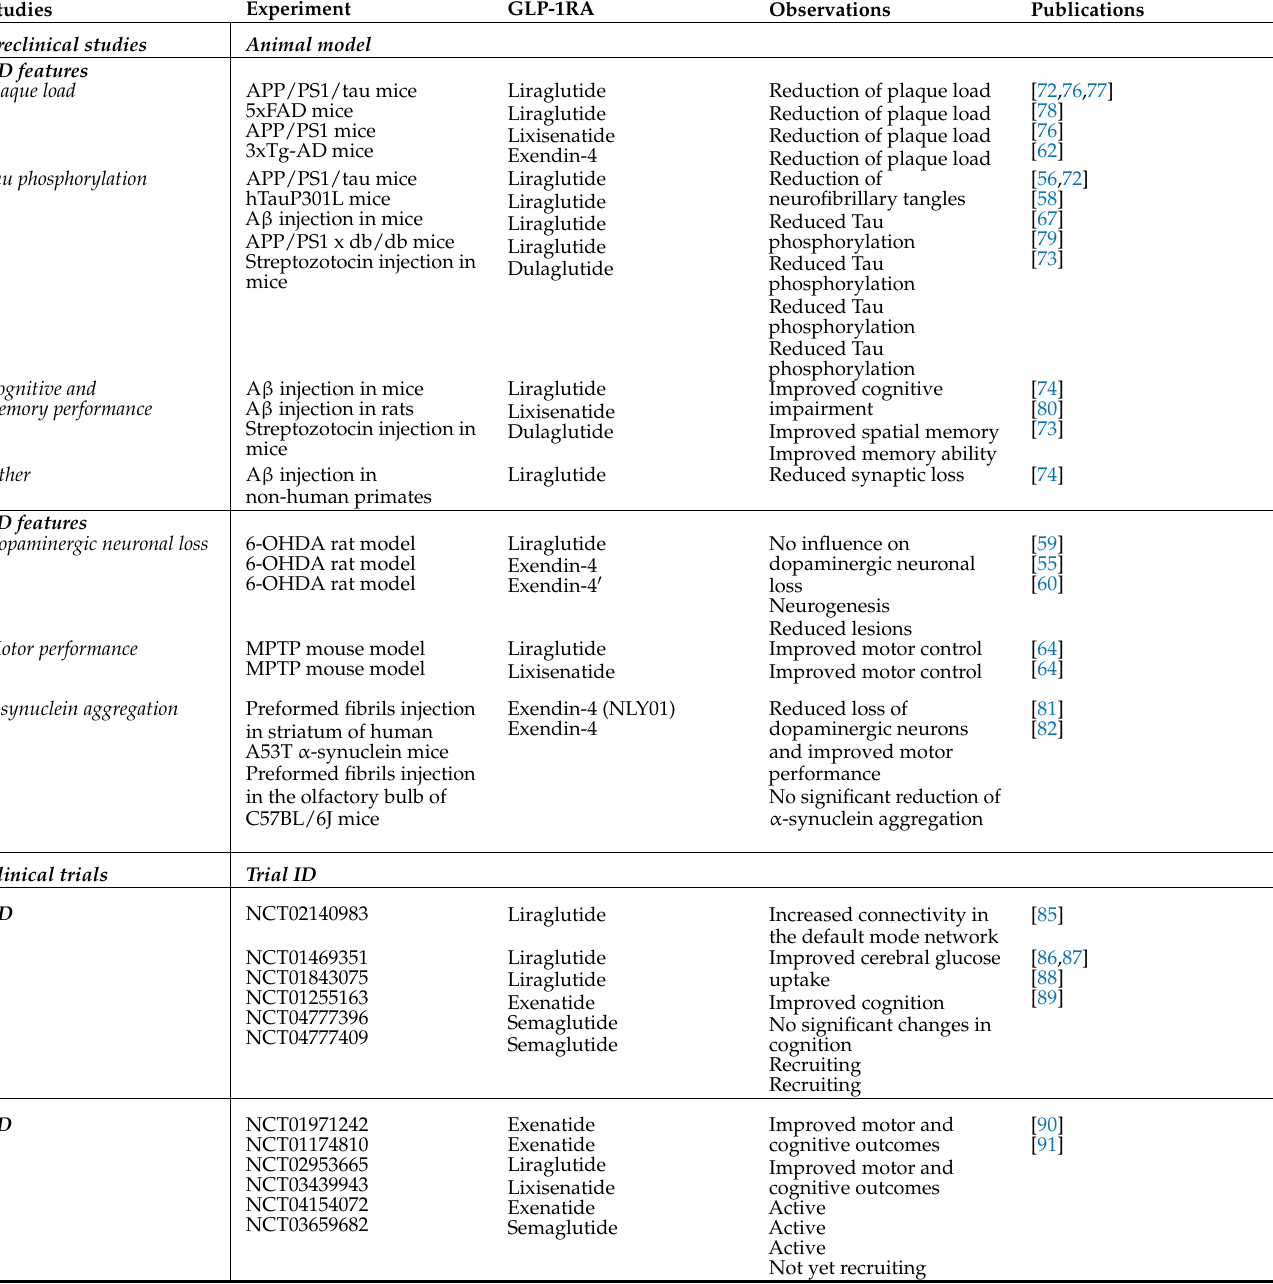
Table 2. GLP-1RAs in AD and PD: An overview of the experimental models and clinical